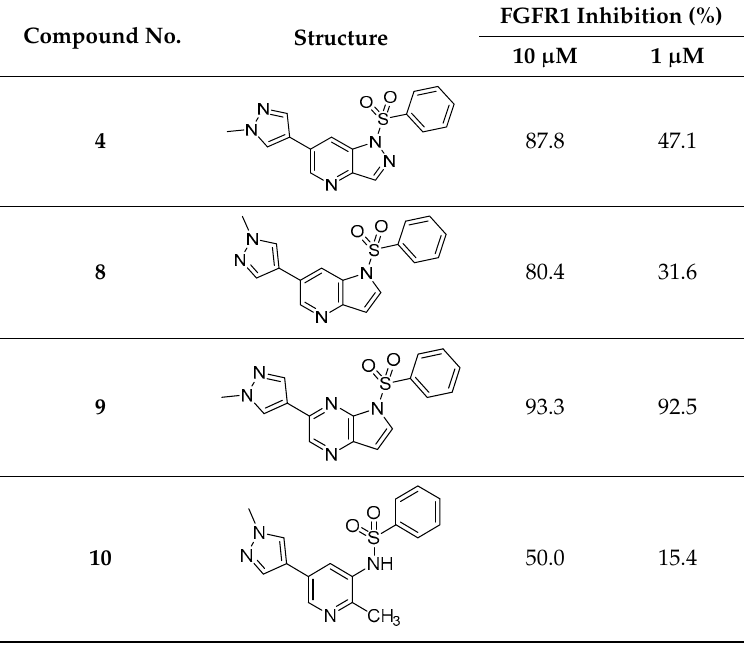
Table 2. Structures and FGFR1 enzymatic activities of compounds 8 – 10 .